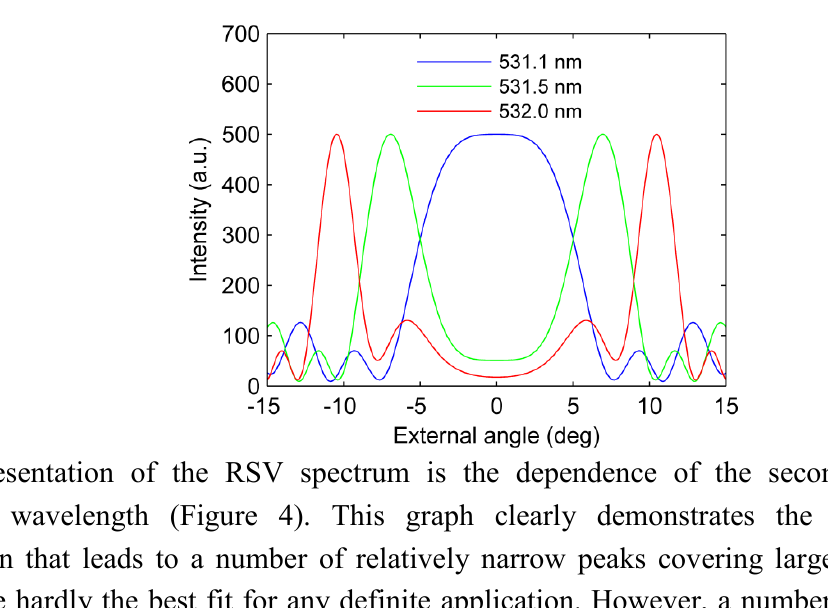
Figure 3. Random Maker fringes for NPC SBO calculated by varying the